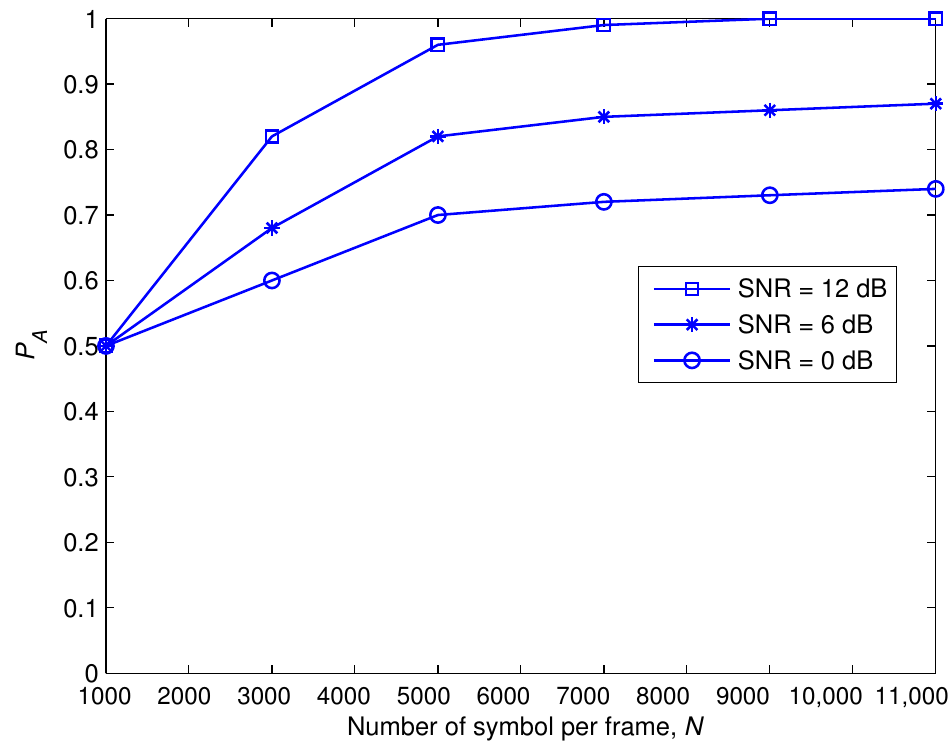
Figure 19. The effect of N on the categorization performance. for the modulation set of Ω 4